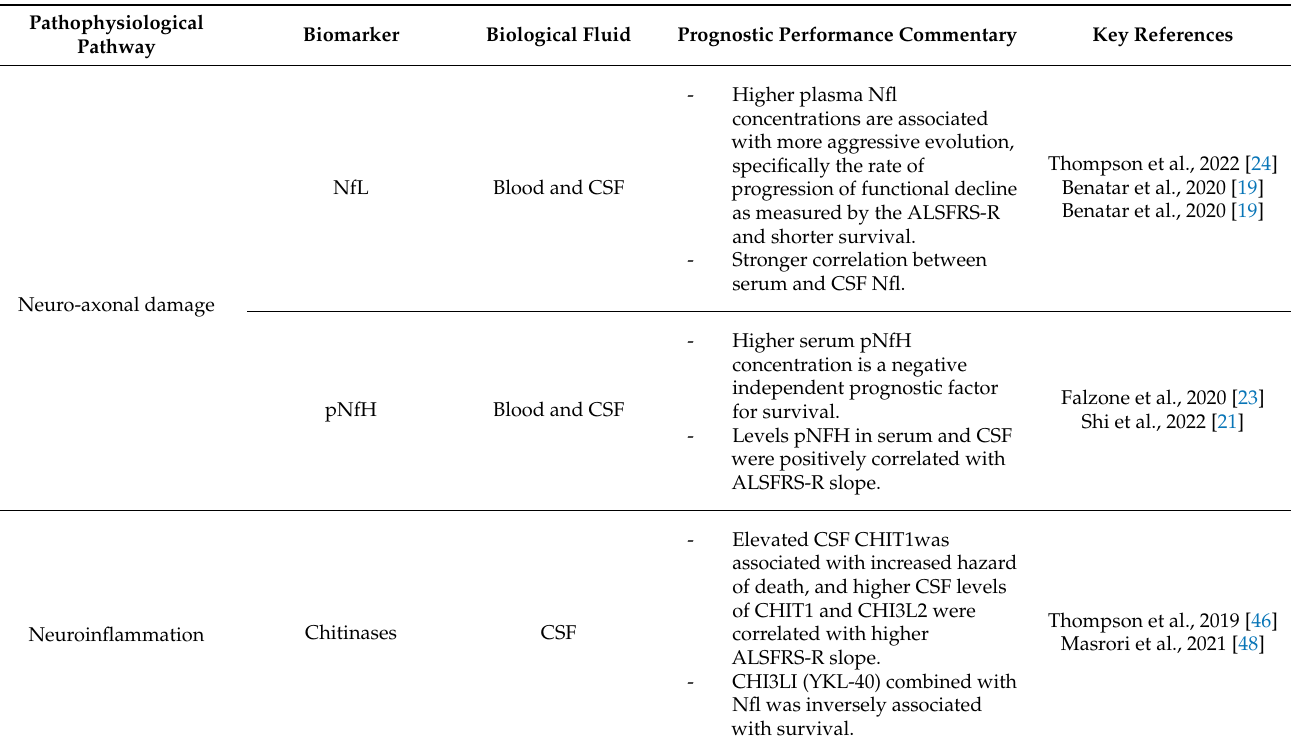
Table 2. Summary of prognostic biomarkers outlined in this review in each pathophysiological